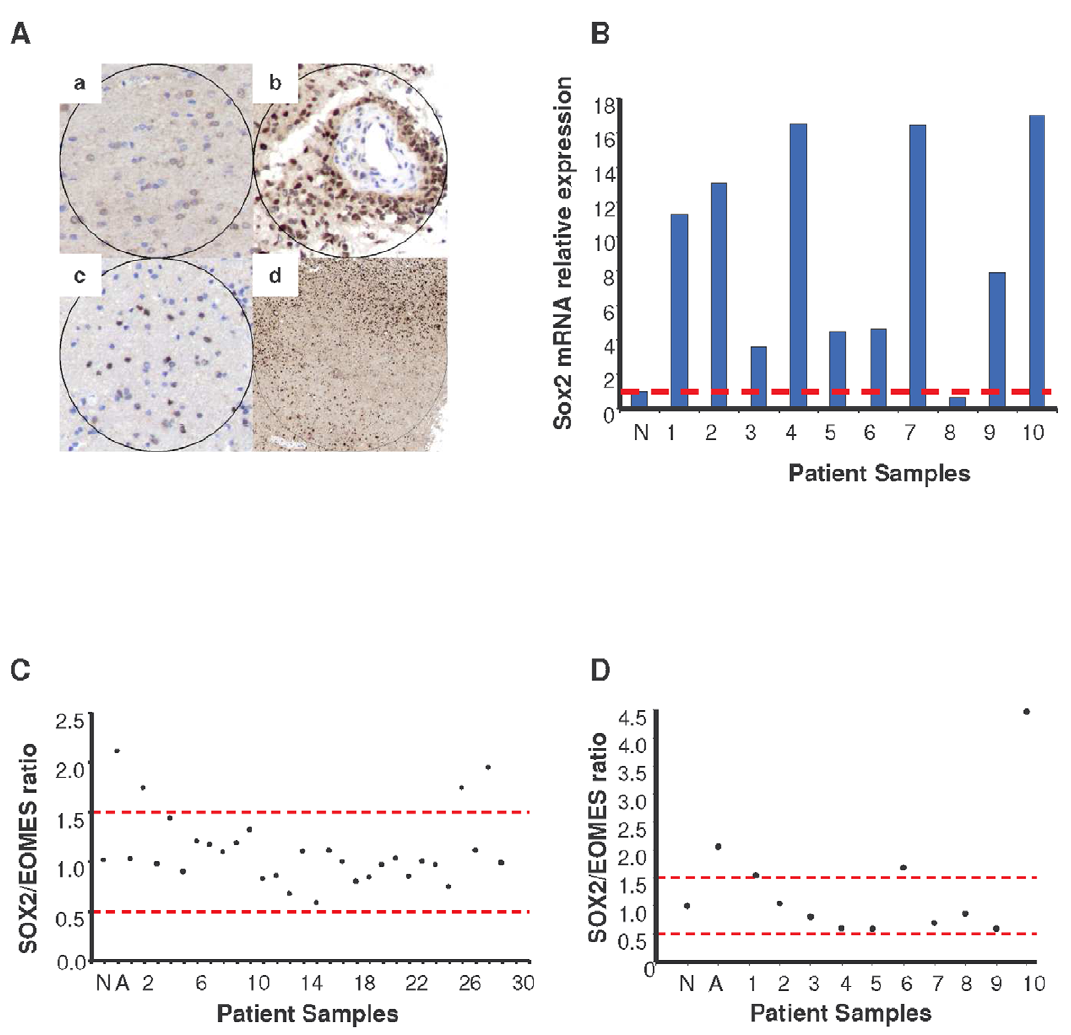
Figure 1. Molecular analysis of Sox2 in GBM specimens. A. Sox2 was overexpressed at the protein level in GBM samples. Representative micrographs of Sox2 immunostaining in GBM samples (n=30). a , normal white matter with slight cytoplasmic staining in the cytoplasm; b , GBM with intense nuclear staining in tumor cells and no vascular staining; c , Sox2-positive infiltrating cells in normal tissue around the tumor (20 6 ); d , infiltrative border with Sox2-positive tumor cells (4 6 ). B. Sox2 was overexpressed at the mRNA level in GBM samples. This panel illustrates the relative Sox2 mRNA expression levels in 10 GBM samples. The red dashed line represents the normal threshold. N=normal brain. C and D. Amplification of Sox2 in the two independent cohorts (left, 30 GBM samples; right, 10 GBM samples). N=normal human astrocytes; A=leukemia cell line TF1 (amplified Sox2). The red dashed lines represent the normal threshold.